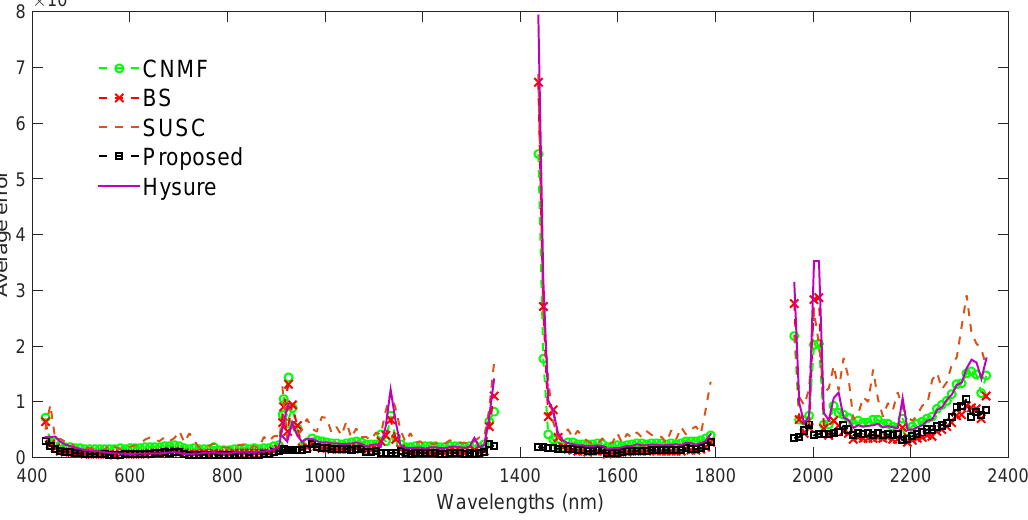
Figure 10. Average squared error between obtained and ground truth spectra of 3734 randomly sampled pixels of the Shiraz dataset (256 × 128) for the different methods. Table 5. Average squared error for the Shiraz